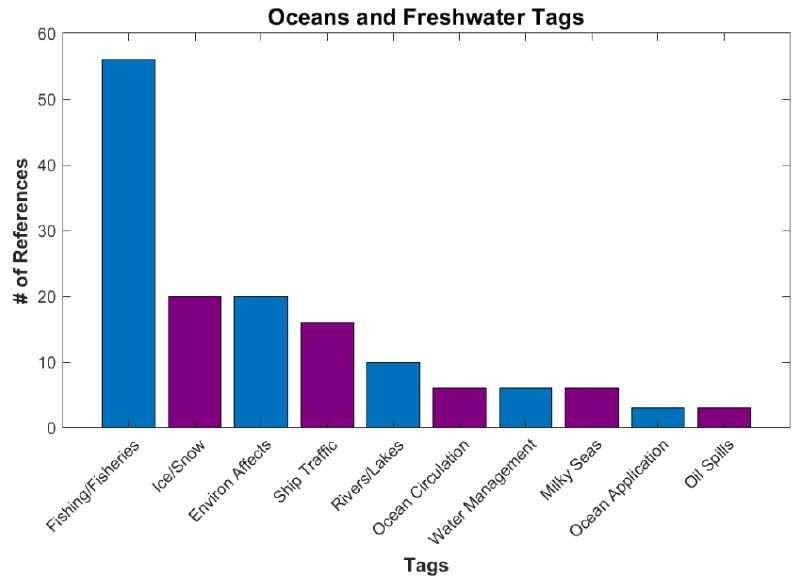
Figure 12. Number of references for various tags under Applications/Oceans and Freshwater.